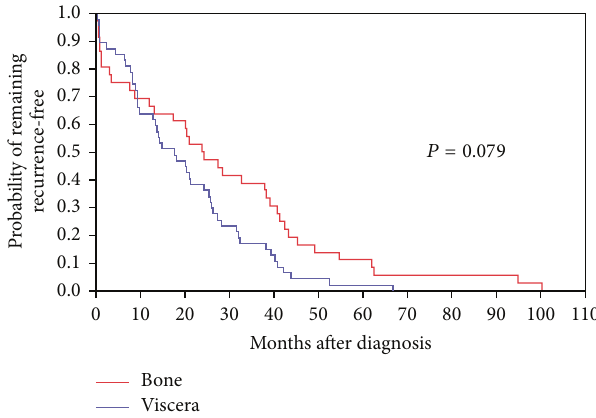
Figure1:Metastatic-freeintervalfordistantboneandvisceral(liver, lung, and brain)